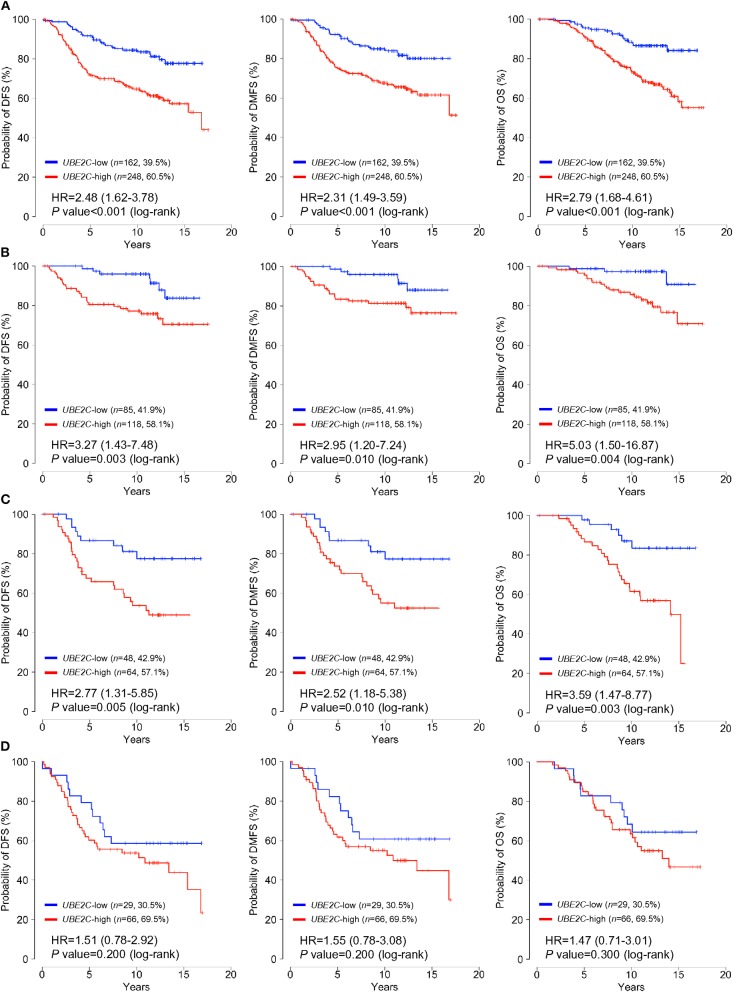
UBE2C mRNA expression is strongly associated with poor survival in patients with HR+/HER2– breast cancer. The impact of UBE2C mRNA expression on DFS (left panels), DMFS (middle panels), and OS (right panels) of (A) all, (B) pN0, (C) pN1, or (D) pN2/N3 patients with HR+/HER2– breast cancer was analyzed using the Kaplan–Meier method.